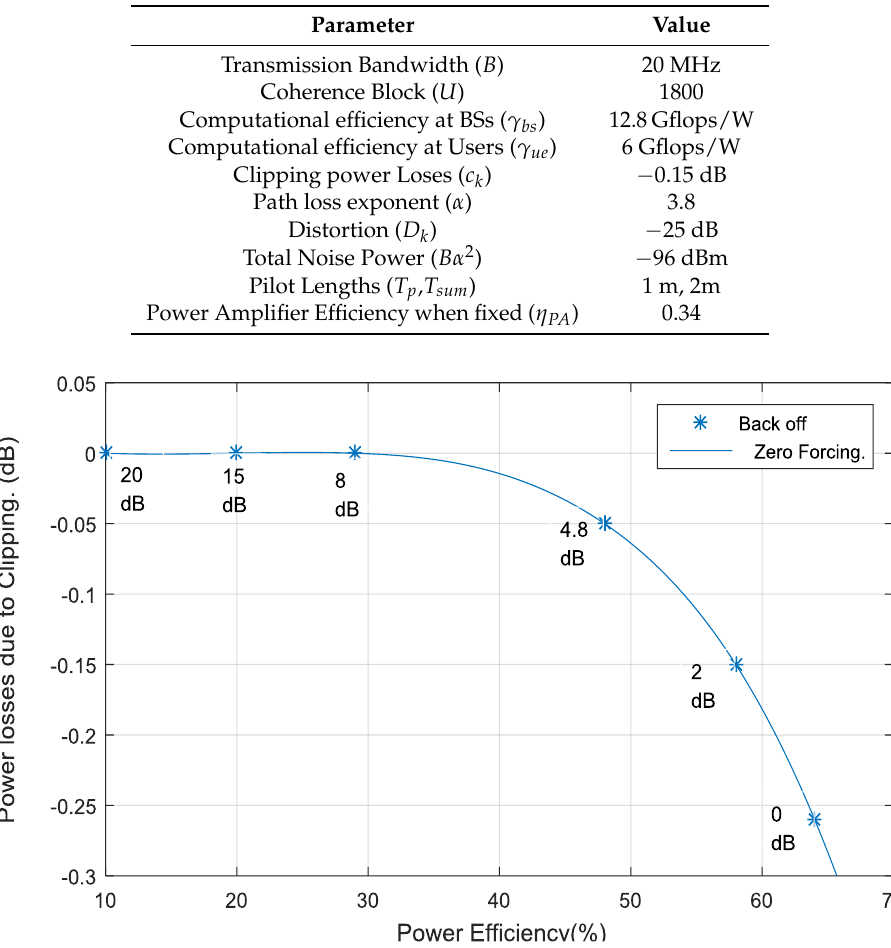
Table 1. Simulation parameters.